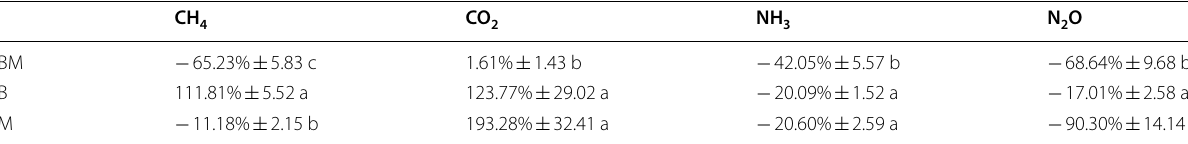
Results are the mean of three replicates microbial agent (0.01% compound microbial agent to 0.1% biochar before being naturally